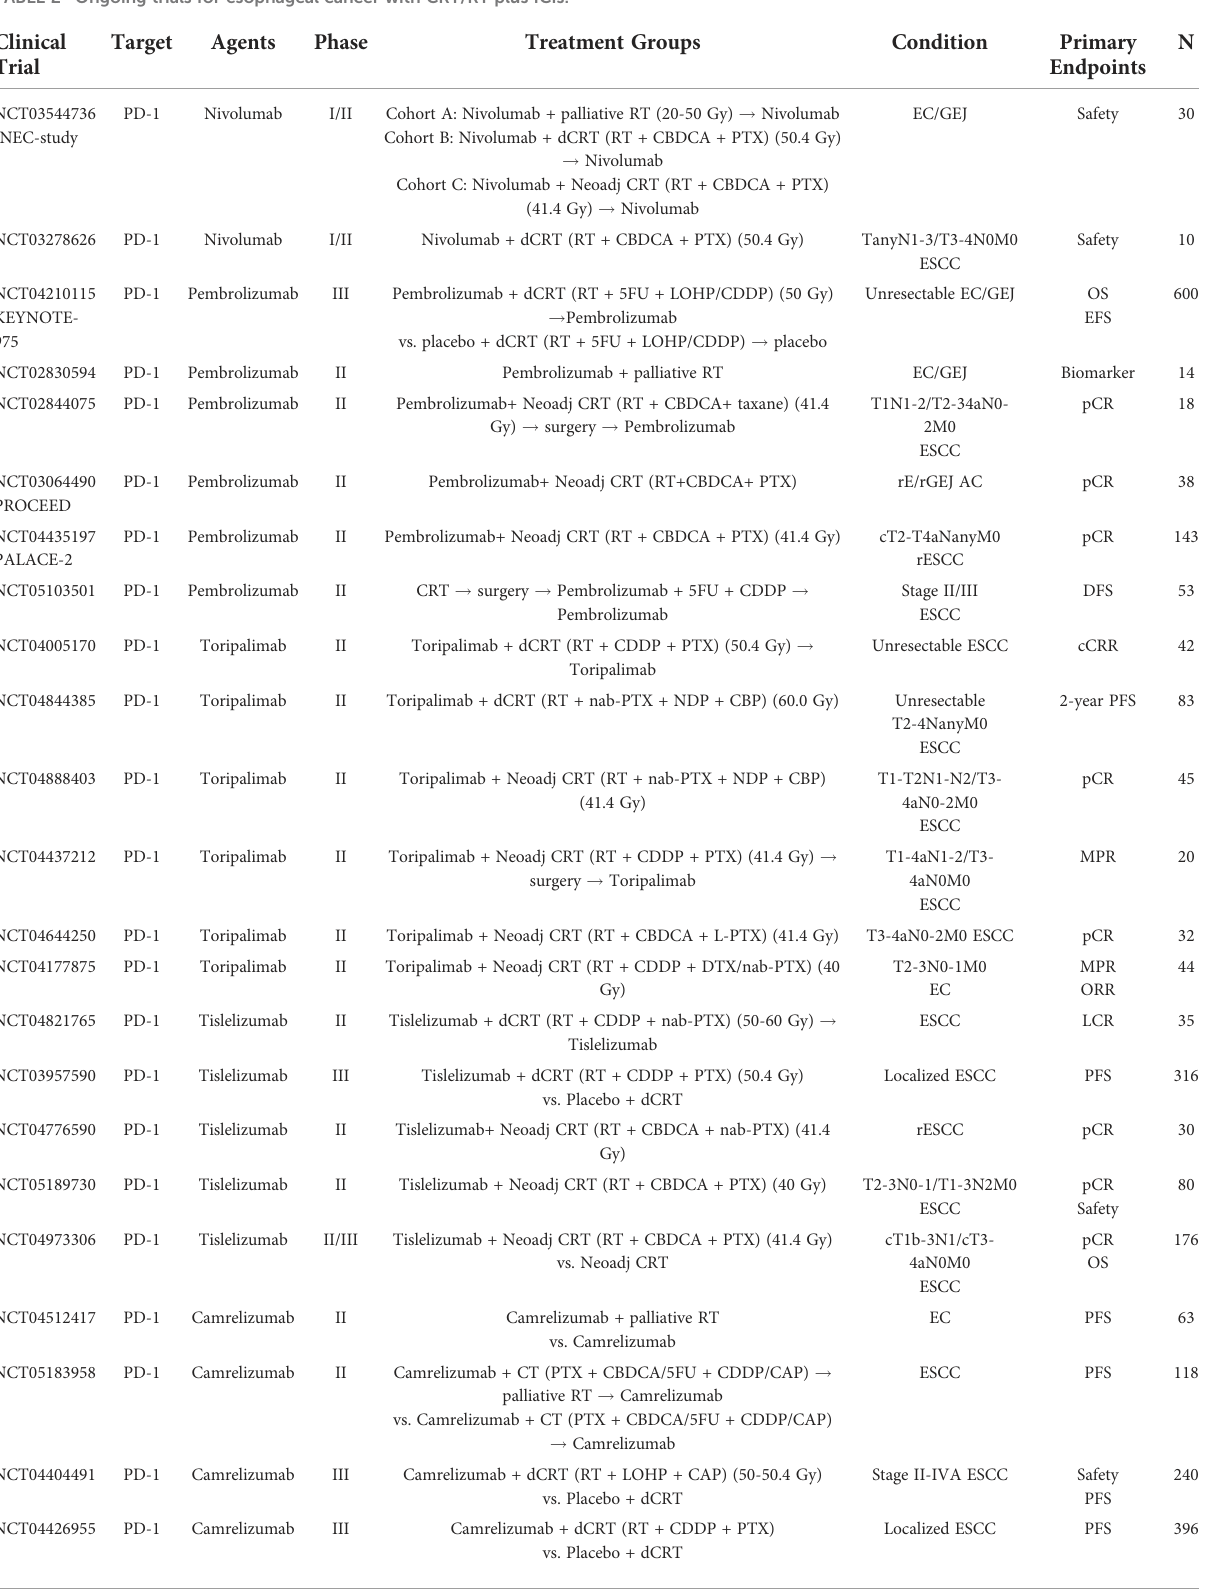
TABLE 2 Ongoing trials for esophageal cancer with CRT/RT plus ICIs. Clinical